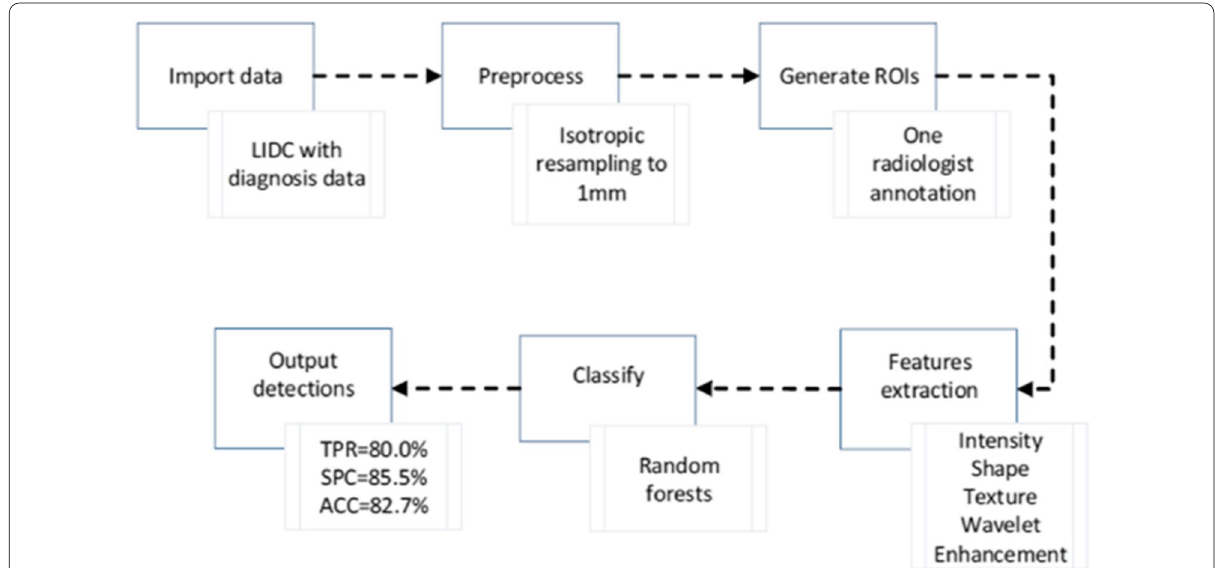
Fig. 6 Workflow of automatic lung nodule classification with radiomics approach [170]